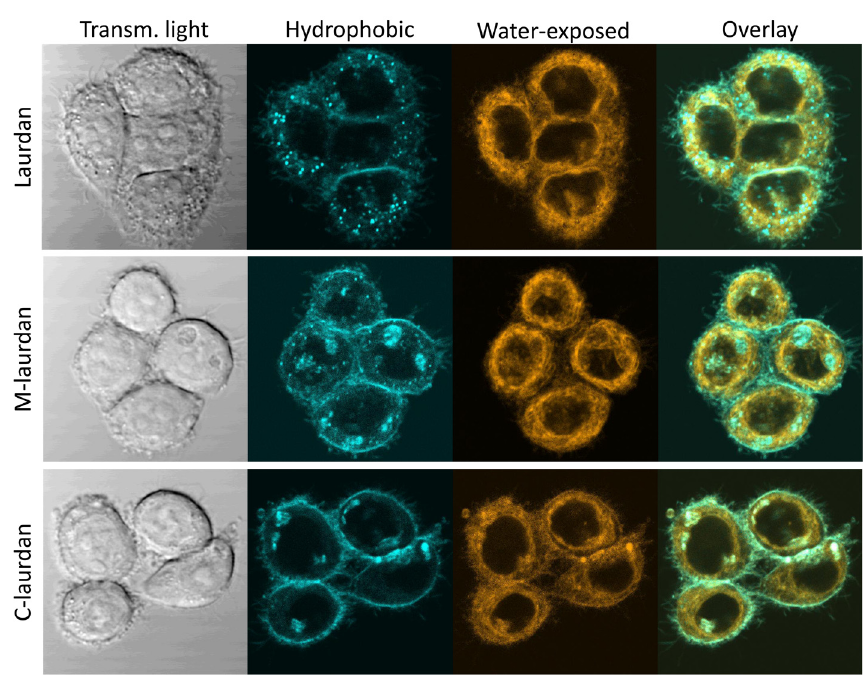
Figure 9. After spectral deconvolution, the staining patterns obtained with Laurdan, M laurdan and C laurdan are rather similar, but C laurdan labels the PM noticeably better than the other two probes. Live Hela cells grown on glass coverslips for two days were labelled with either 2uM Laurdan (top row), 500 nM M-laurdan (middle row) or 200 nM C-laurdan (bottom row) as described in M&M. Lambda stacks were then acquired on live cells kept at 37°C with our bi-photon microscope, and spectral deconvolution carried out, all with the